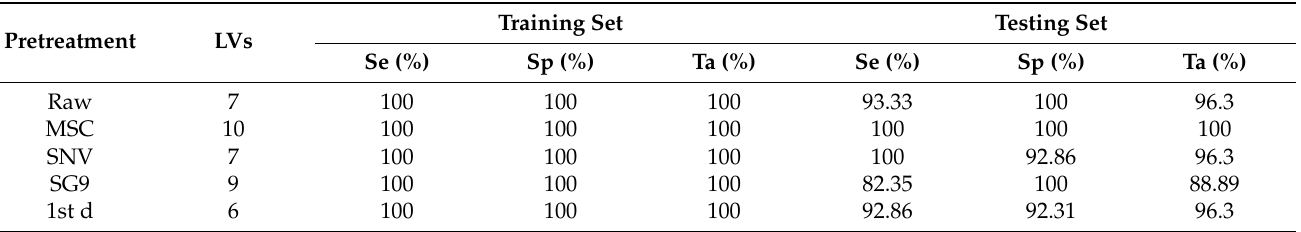
Table 3. The discrimination results of the PLS-DA model based on NIR spectra (in the region of